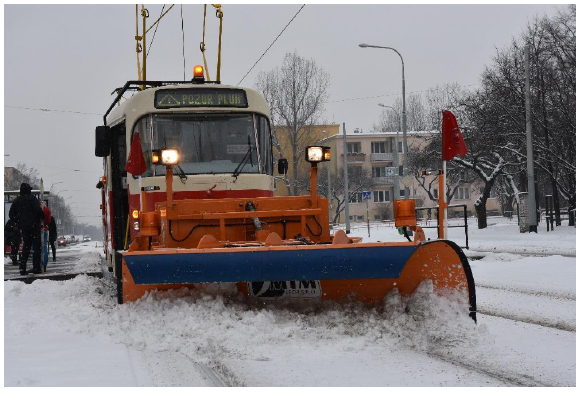
Figure 1. PSP-01 snow plough